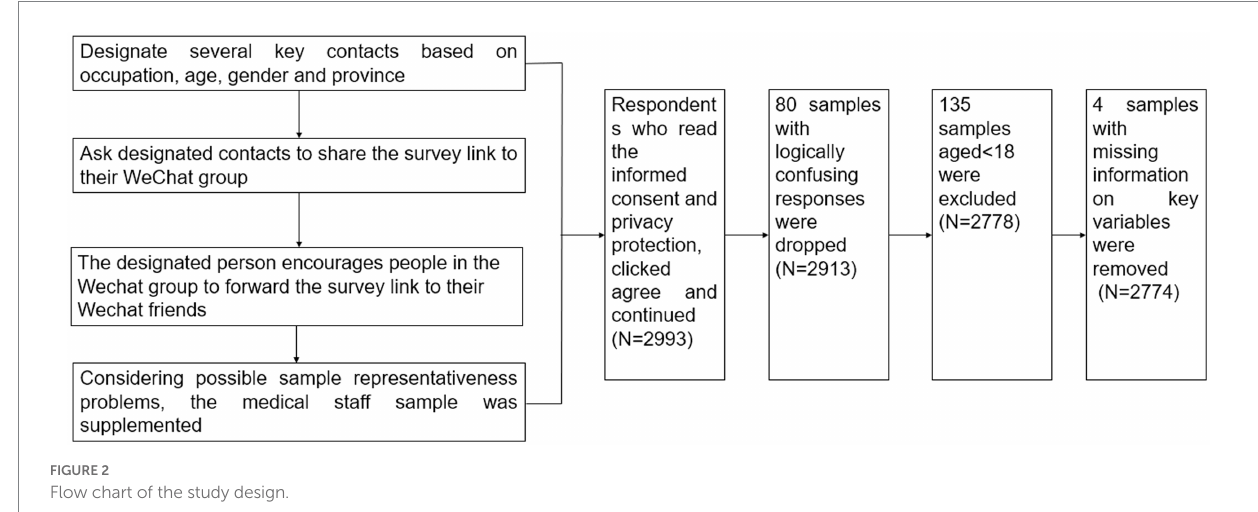
FIGURE 2 Flow chart of the study